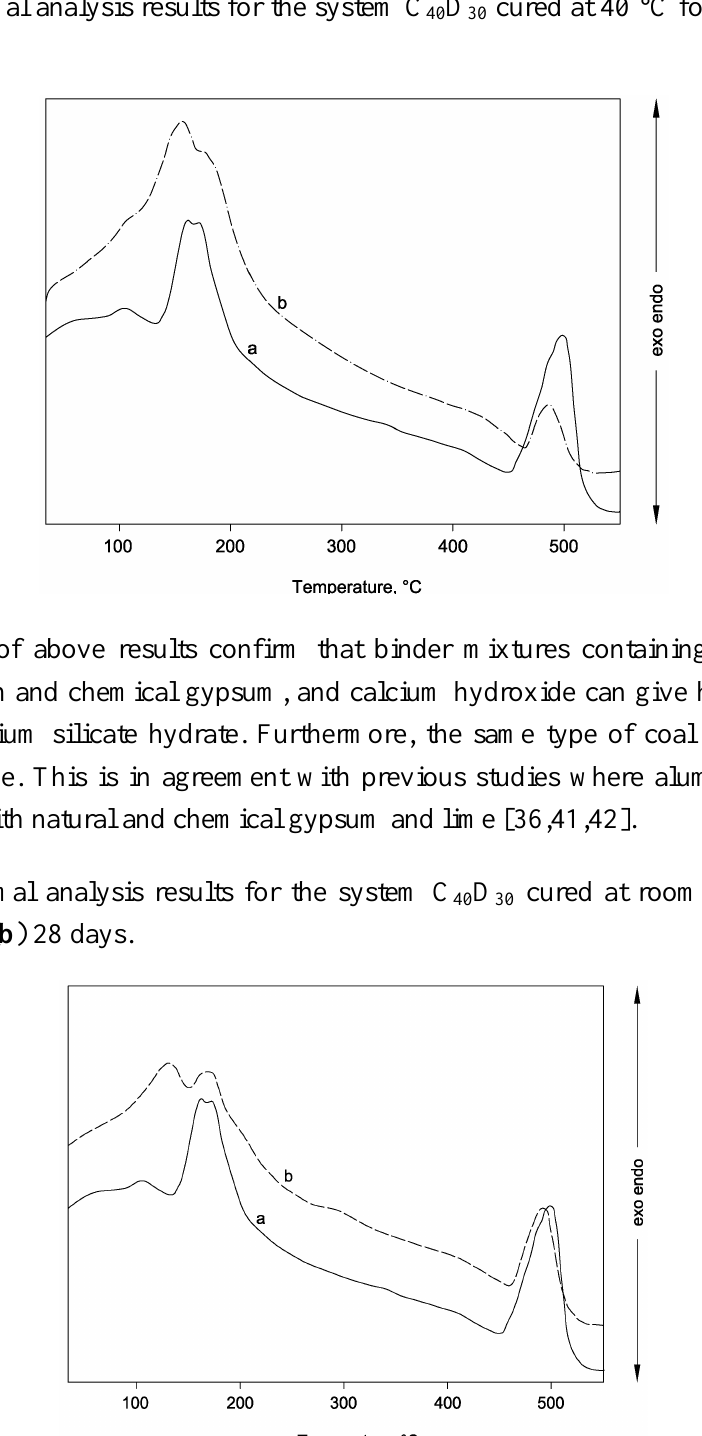
D cured at 40 °C for ( a ) 7 days; and 40 30